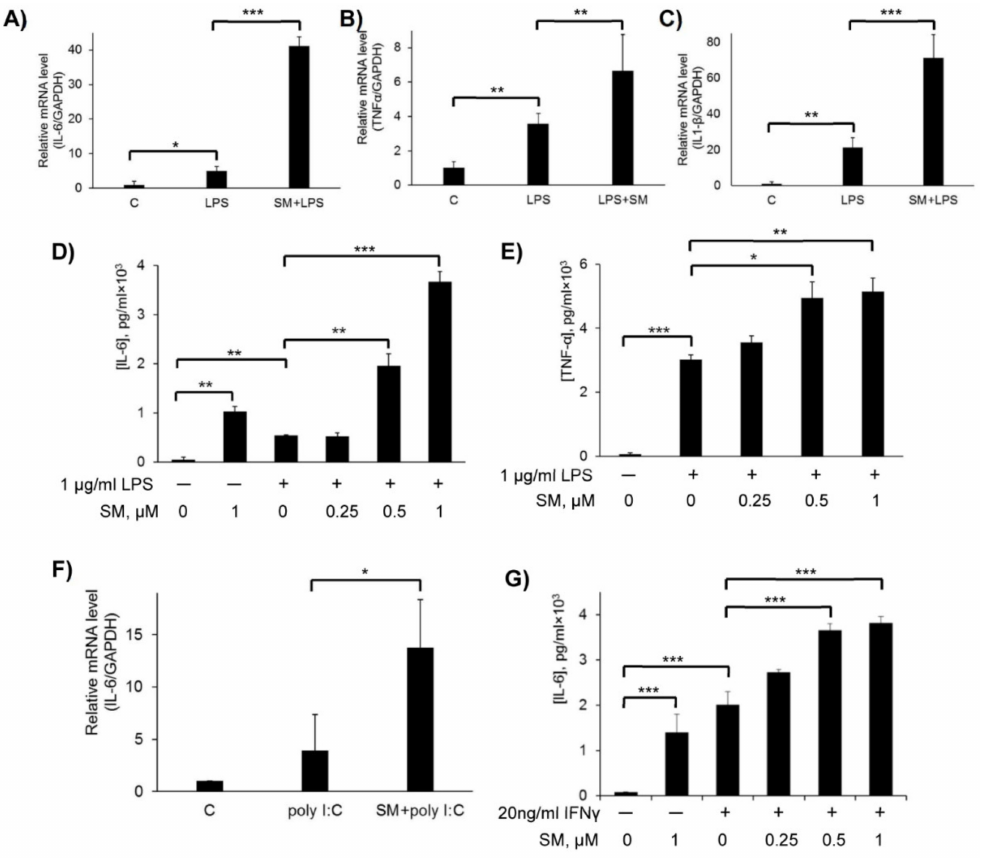
Figure 5. E ff ects of SM on the expression of inflammatory mediators. Raw 264.7 cells were treated with SM (0.5 µ M), LPS (1 µ g / mL), or SM + LPS ( A – E ) poly (I:C) and SM + poly I:C ( F ) or IFN γ and SM + IFN γ ( G ) for 24 h. After incubation, mRNA levels of interleukin-6 (IL-6) ( A , F ), tumour necrosis factor- α (TNF- α ) ( B ), and interleukin-1 β (IL1- β ) ( C ) were analyzed by RT-q PCR. The secretion of IL-6 ( D , G ) and TNF- α ( E ) in cell culture supernatants was analyzed by ELISA. In all the experiments, untreated cells were used as the control (designated by ( C )). Values are expressed as the mean ± SD of three independent experiments; * p < 0.05, ** p < 0.01, and *** p < 0.001. NF- κ B is a transcription factor that regulates the expression of inflammatory